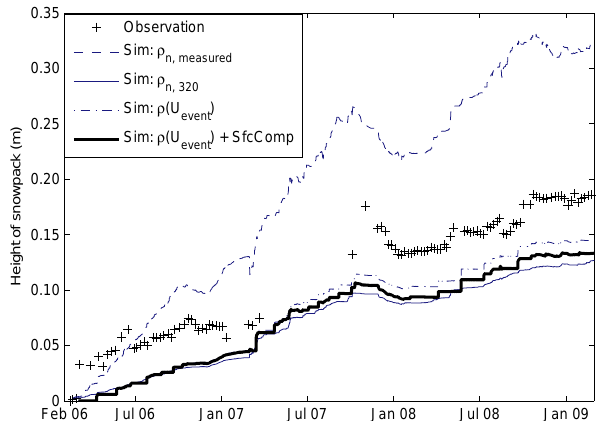
Fig. 5. Height of snowpack (m) relative to the snow layer which was at the surface on 15 February 2006. Stake measurements are indicated by crosses, and lines represent results from SNOWPACK simulations using as input either the measured density of solid de- posits (“ ρ n , measured ”), a fixed density of 320kgm − 3 (“ ρ n , 320 ”), both at precipitation time, or the event-driven mechanism without (” ρ(U event ) ”) or with additional compaction due to wind at the sur- face (“ ρ(U event ) +